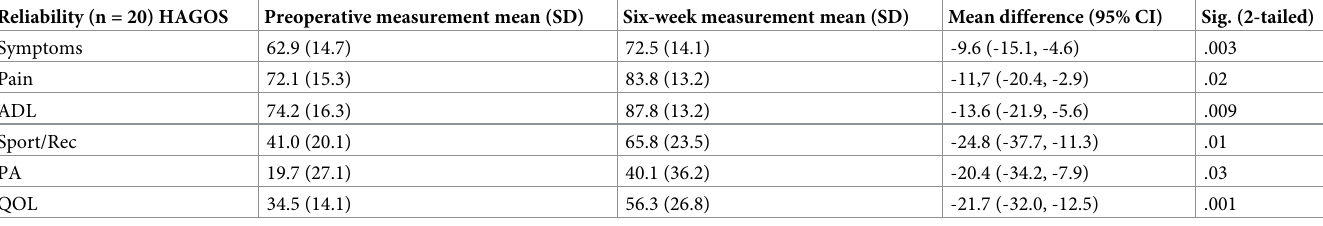
Table 3. Bootstrap for paired samples test of HAGOS subscales, based on 5000 bootstrapped samples. Reliability (n = 20)